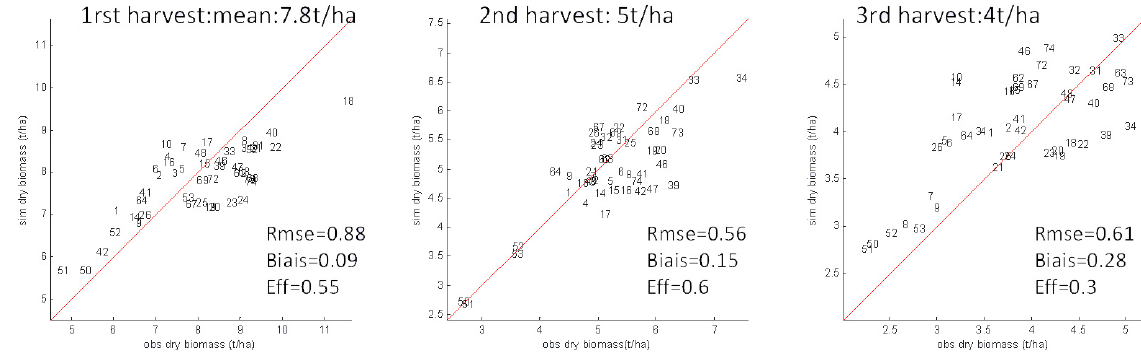
Fig. 9. Comparison between biomass observed and simulated by STICS for the 47 fields of the studied farm. Table 5. Comparison between STICS simulations where main inputs (LAI, cut and irrigation dates) varied for the period 1 January–31 October 2006 (forced meant computed from remote sensing data, simulated: computed by the model; cases 1 and 2, only one simulation was performed and compared to the average of yields observed over the 47 fields surveyed + rmse, for the other cases, rmse: relative standard error and bias were